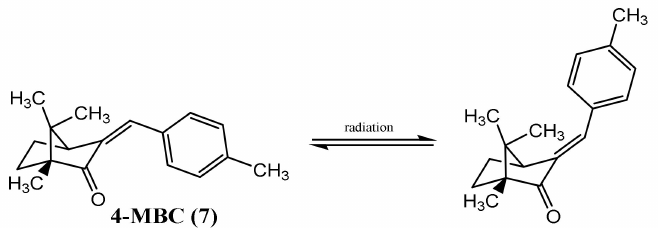
Figure 1. Interconversion between E and Z isomers when 3-(4-methylbenzylidene) camphor ( 4-MBC ) ( 7 ) is exposed to UV